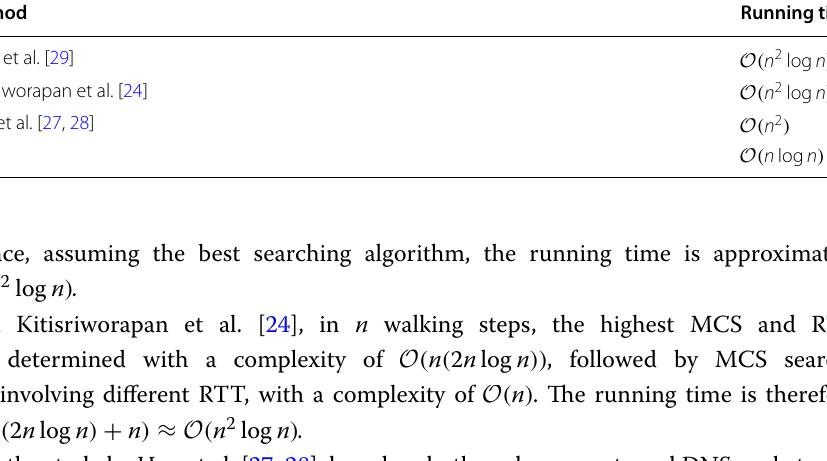
Table 2 Running‑time analysis